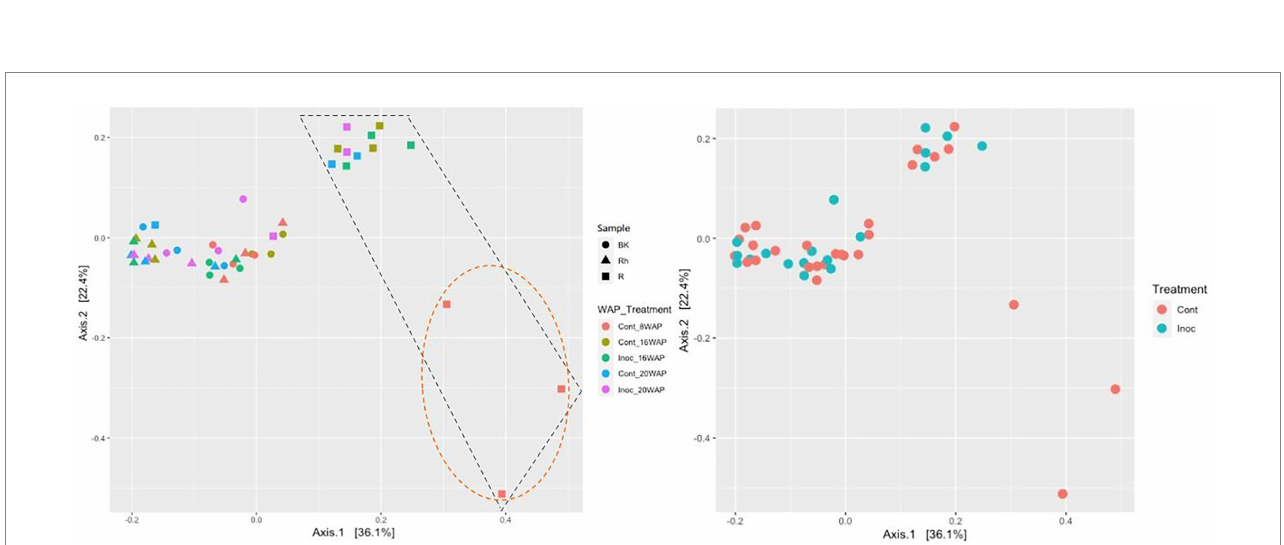
FIGURE 3 Principal coordinates analysis of the bacterial communities in each sample type (Left) and under each treatment (Right) generated based on weighted UniFrac distances using permutational analysis of variance (PERMANOVA; Adonis function; 999 permutations) on QIIME2. Cont, control non-inoculated treatment; Inoc, inoculation treatment; WAP, weeks after planting; R, root; Rh, rhizosphere; BK, bulk soil. The R bacterial structures were clustered separately from the other samples as shown in the black dashed box. At 8 WAP, the R bacterial structures were grouped separately from the other R samples as shown in the orange dashed